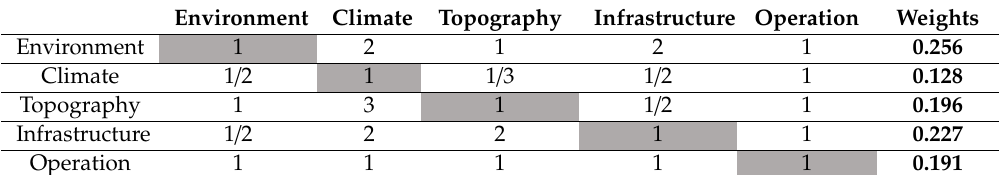
Table 6. The weighs of main criteria.